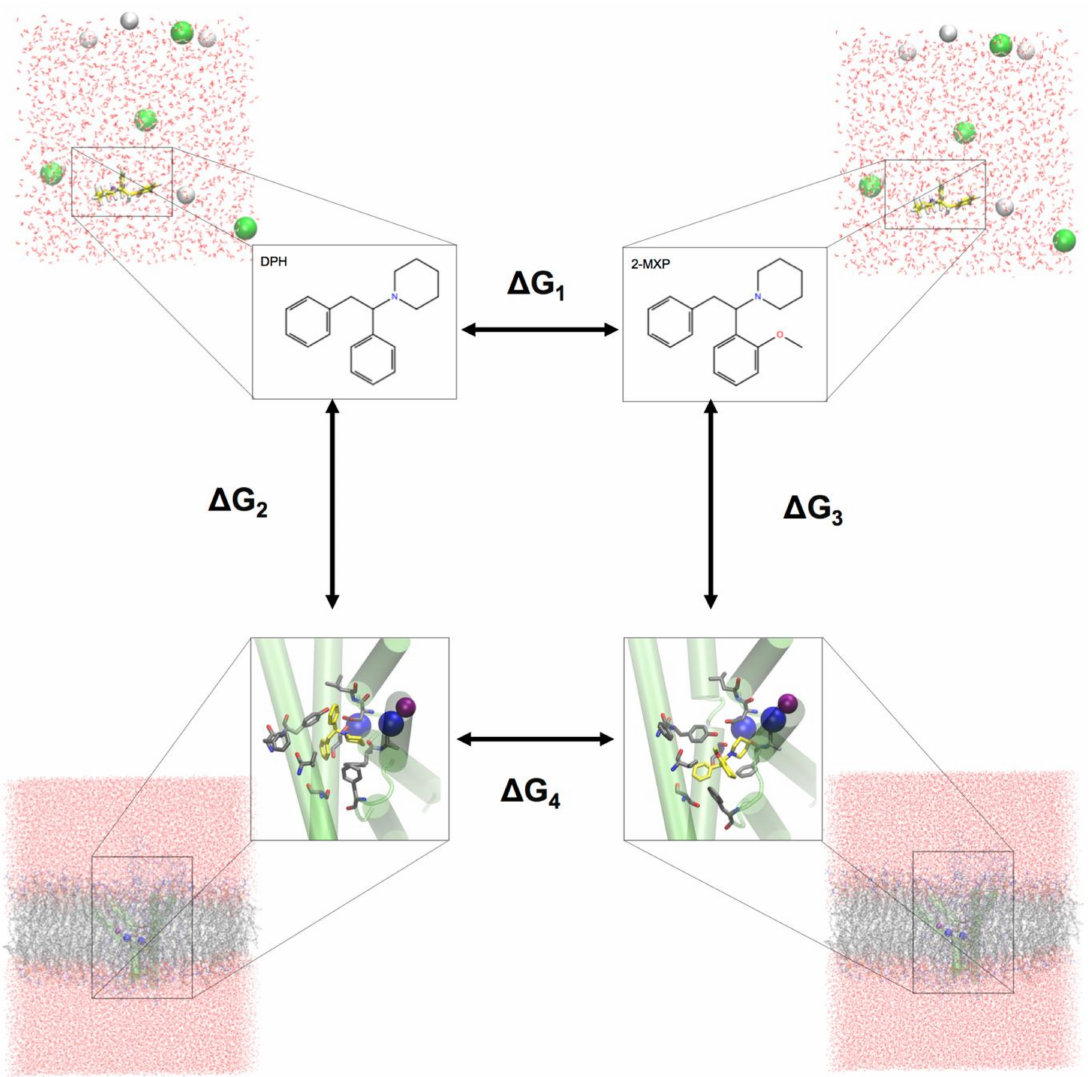
Figure 2. The thermodynamic perturbation cycle between the compounds DPH and 2-MXP. A similar cycle would apply to the free energy change from DPH to the other three compounds (2-Cl-DPH, 3-MXP and 4-MXP). Here we highlight the complexity of the full systems in each step of the transformation as well as the components (compounds, protein, ions and membrane) that are boxed. ∆ G 1 represents the unbound solvent (ligand in water) state while ∆ G 4 represents the bound (protein-ligand complex in water)